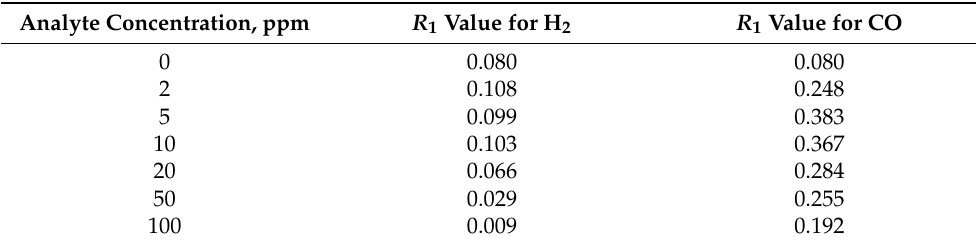
Table 1. The decimal logarithm of the ratio of electrical conductivities R 1 of the SnO 2 –PdO x sensor, at the beginning and at the end of the last third of the measurement cycle for hydrogen and carbon monoxide in the